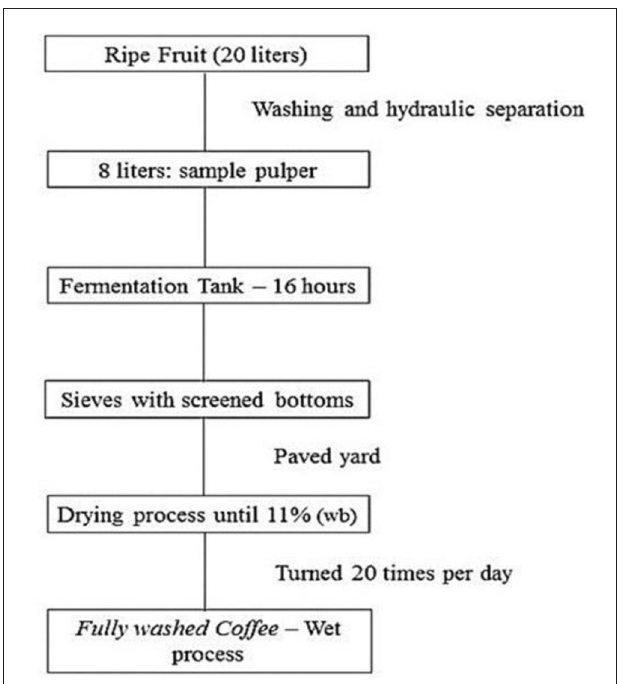
FIGURE 2 | Biplot of the first two main components PC1 (95.88%) and PC2 (2.03%) for data from 31 elite genotypes of C. arabica wet processed according to the sensory attributes and final sensory